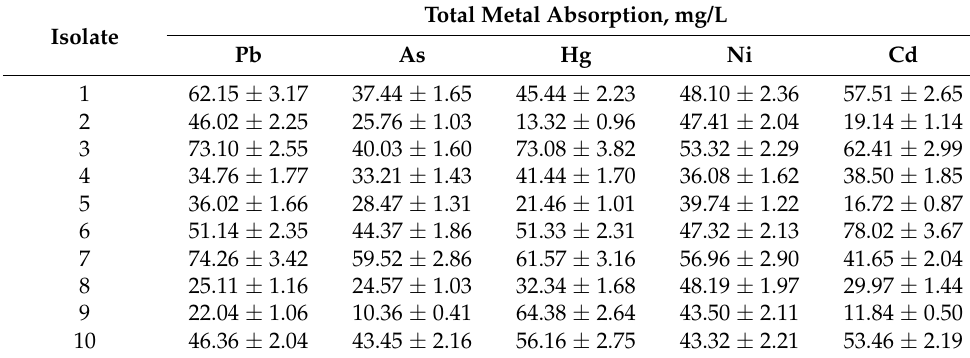
Table 2. Total absorption of individual